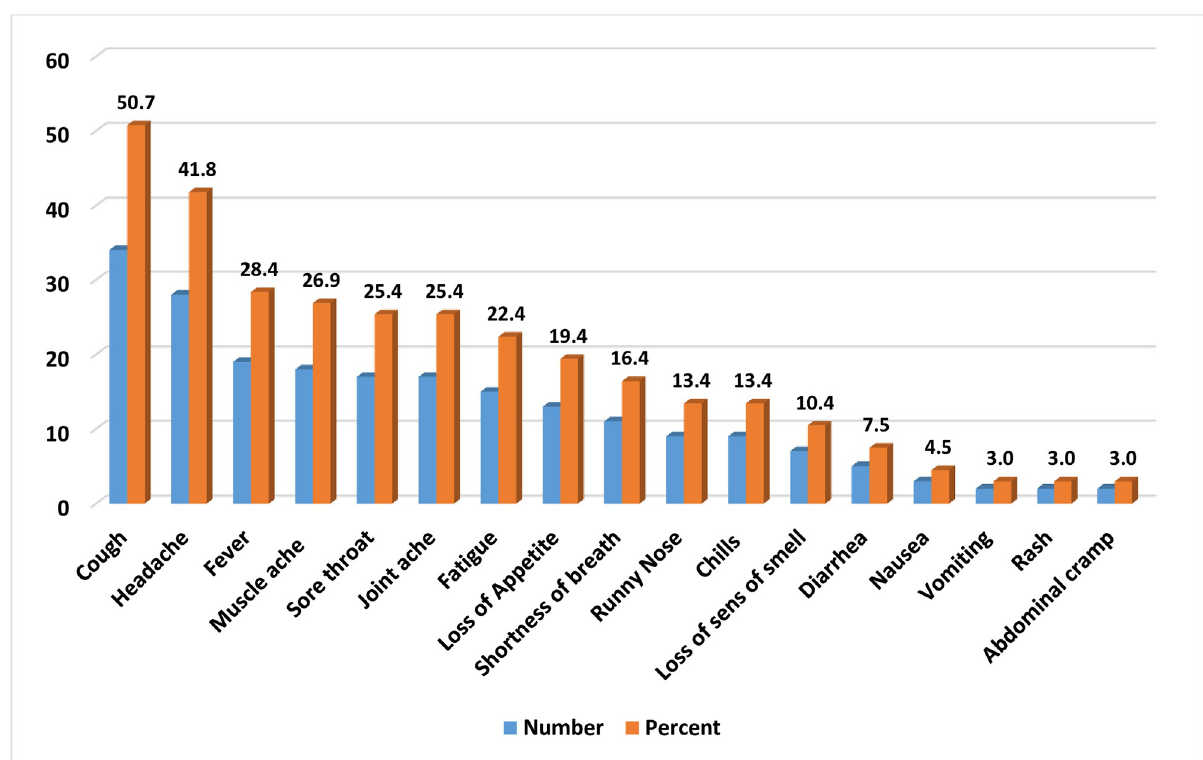
Fig 1. Signs and symptoms observed in the study participants at Eka Kotebe General Hospital, COVID-19 Isolation and Treatment Center, 2020.